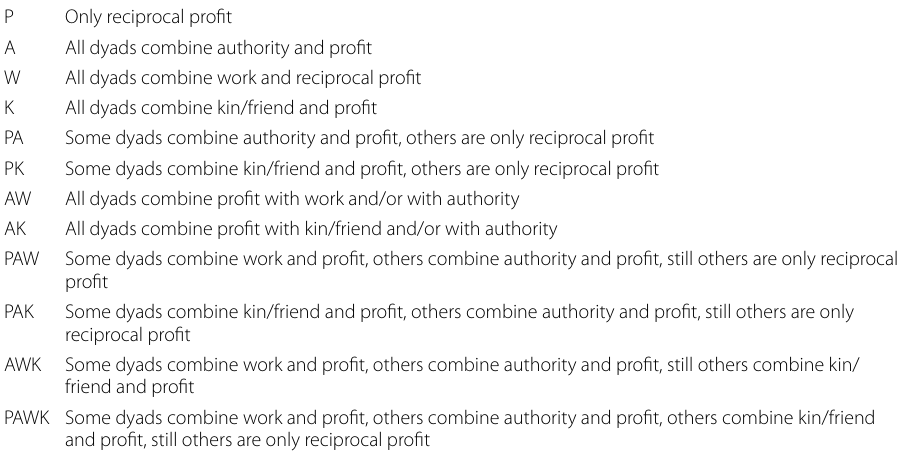
Table 4 Twelve groups of role